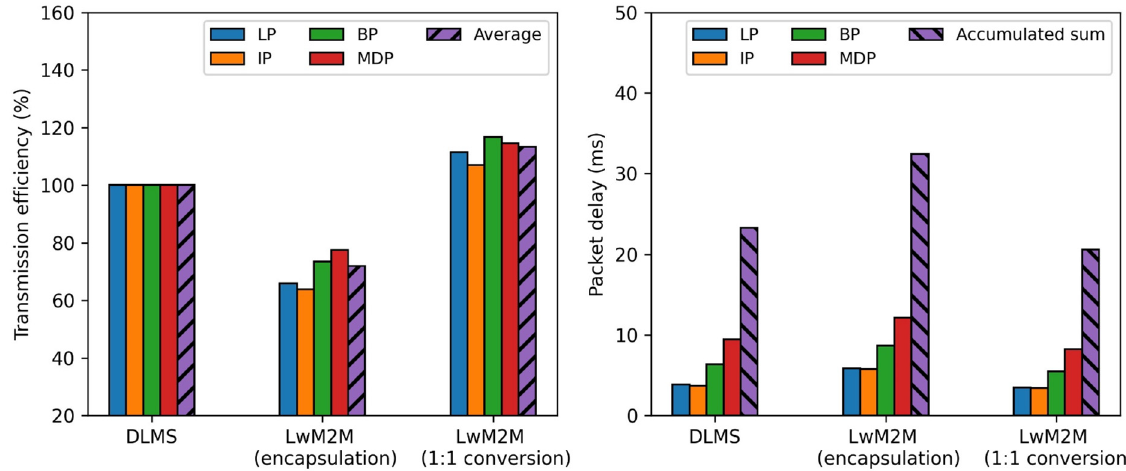
Figure 10. Comparison of the performance metrics (authenticated encryption).